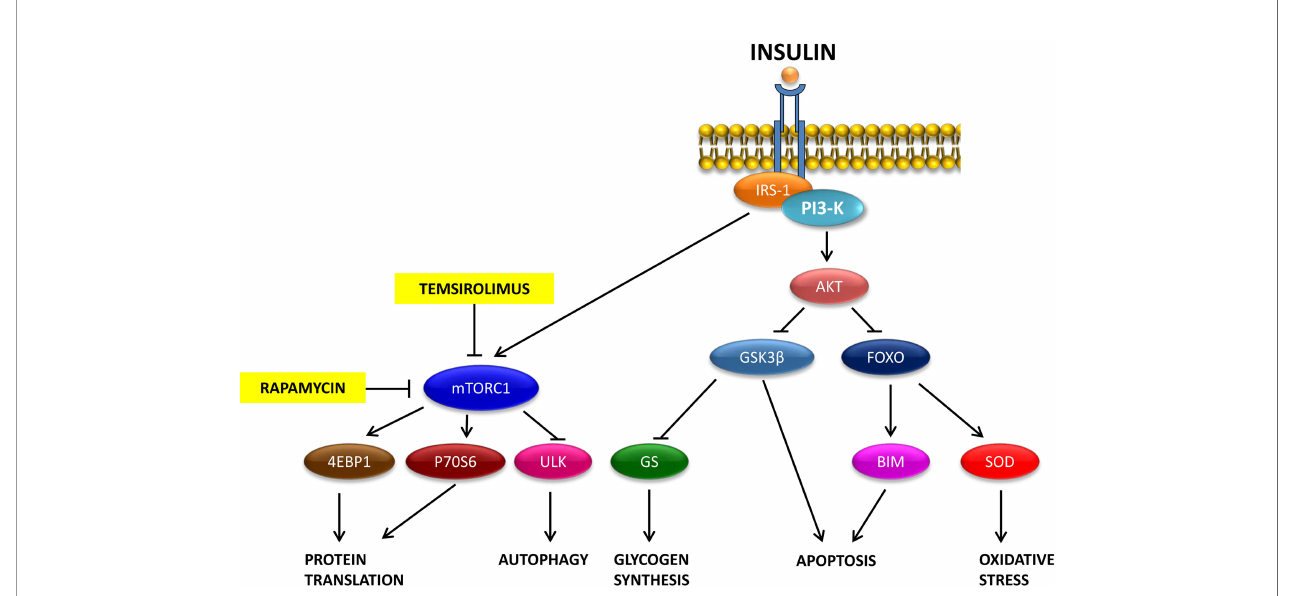
FIGURE 3 | Mechanisms through which rapamycin and temsirolimus prevent the function of the mTORC1